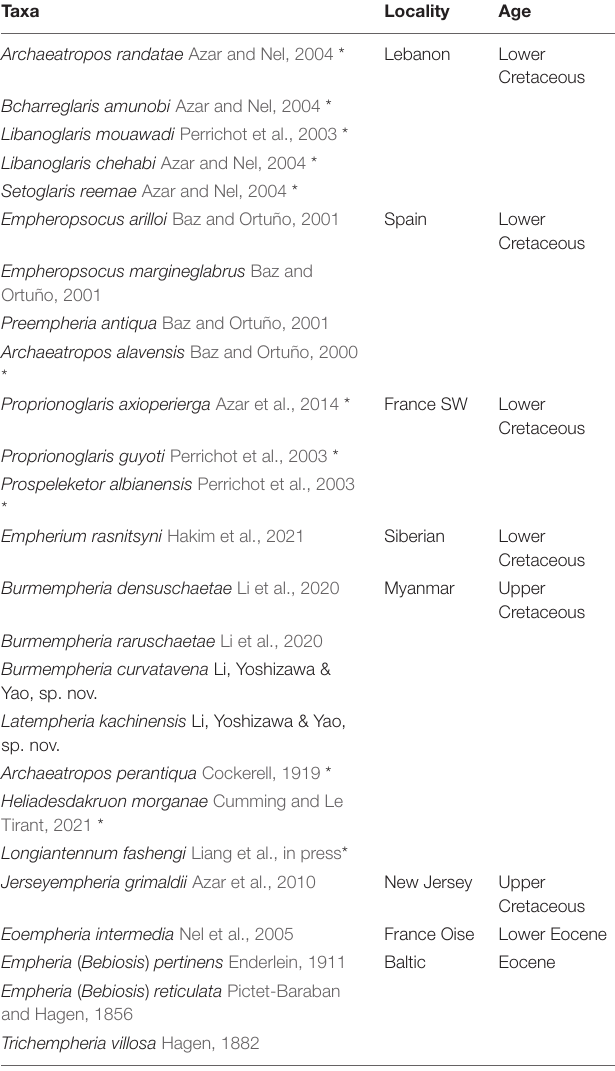
TABLE 1 | Genera and species of